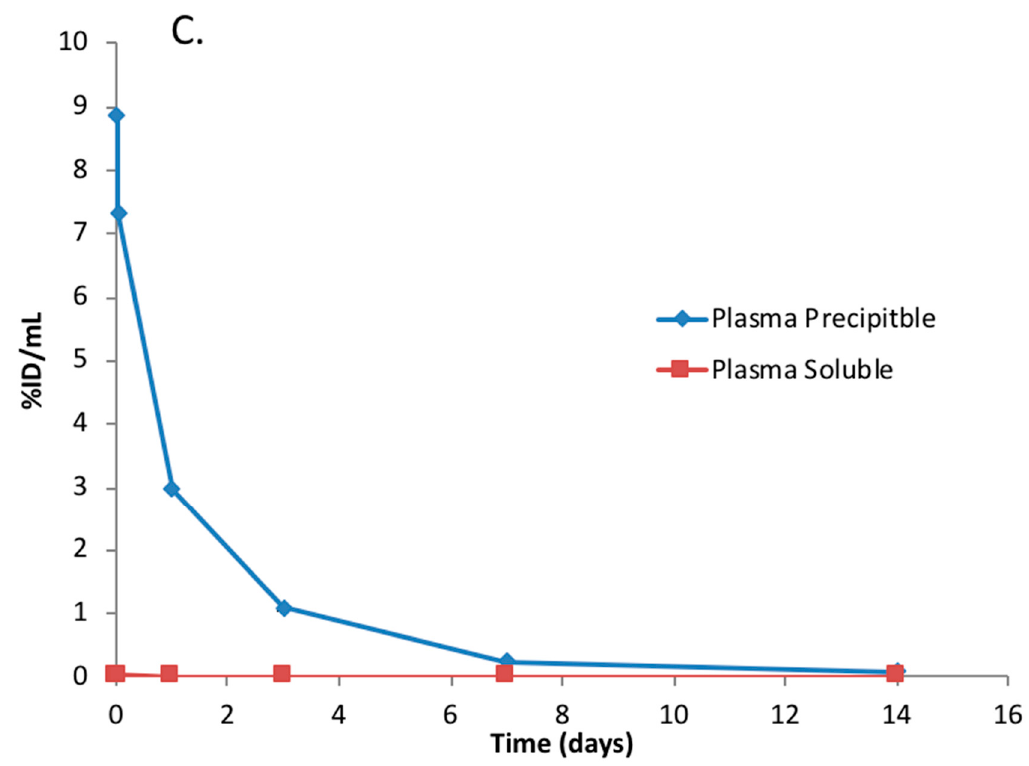
Figure 5. Profiles of the blood radioactivity levels vs. time of radiolabeled polatuzumab vedotin following a single IV administration. ( A ) Radioactivity of [ 125 I]-polatuzumab vedotin (as a percentage of the injected dose) comparing with [ 125 I]-polatuzumab antibodies in plasma in rats at tracer ( ≈ 3 ug/kg) and tracer plus 10 mg/kg dose levels up to 14 days post administration. The data are represented as the mean ± SD. n = 3 per time point. ( B ) Radioactivity of [ 3 H]-MMAE-polatuzumab vedotin (as a percentage of the injected dose) from the whole blood, plasma, and cell pellets in rats up to 14 days post administration. The data are represented as the mean ± SD. n = 3 per time point. ( C ) Plasma from the rats dosed with [ 3 H]-MMAE-polatuzumab vedotin were further processed using organic solvent precipitation, which showed that most of the radioactivity was in the precipitable fraction, suggesting that the MMAE payload was still conjugated to the antibodies in the plasma.